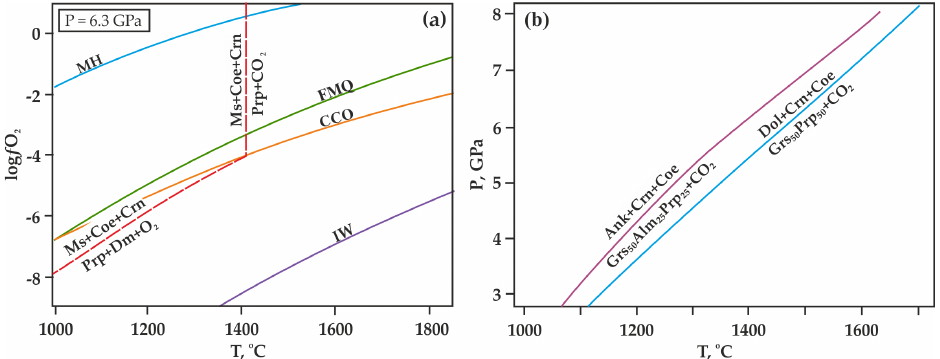
Figure 6. T-ƒO 2 diagram ( a ) with lines of buffer equilibria (according to [60–62]), as well as the decarbonation reaction [53] and P,T diagram ( b ) with the theoretical positions of decarbonation reactions involving ankerite and dolomite, as calculated in this paper [58,59]. MH (magnetite-hematite), FMQ (fayalite-magnetite-quartz), IW (iron-wüstite), CCO—buffer equilibria; Ms—magnesite, Coe—coesite, Crn—corundum, Prp—pyrope, Mgt—magnetite,